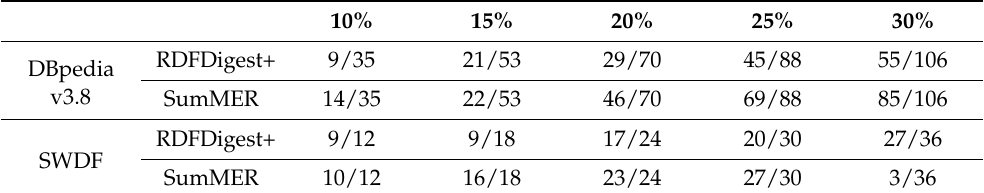
Figure 8. Coverage for testing on SWDF. Table 8. TP values for SumMER and RDFDigest+ for SWDF and DBpedia v3.8.